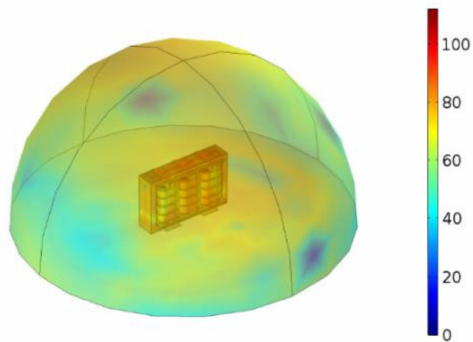
Figure 12. Sound pressure distribution at rated, short-circuit condition (dB).